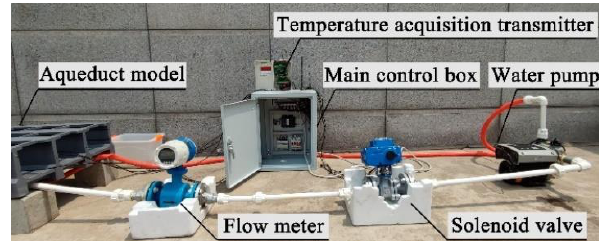
Figure 13. Structure diagram of the experimental system.